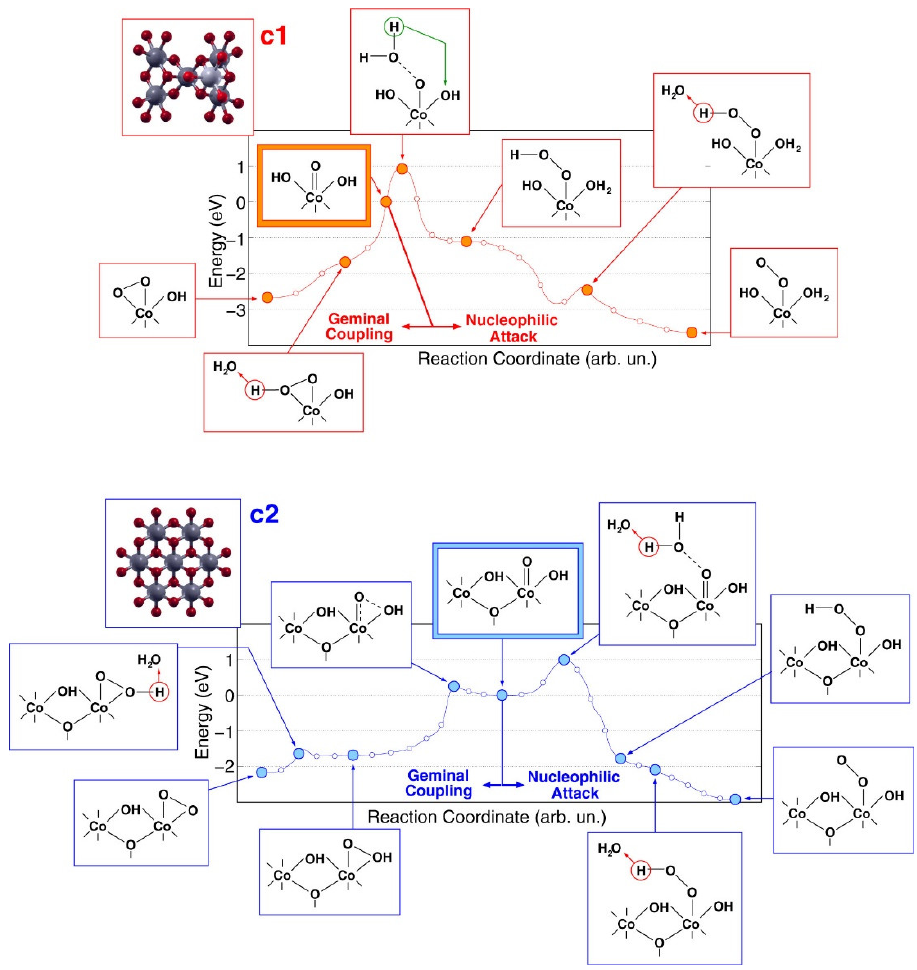
Figure 21. Reaction paths for oxygen evolution promoted by the c1 and c2 CoCat models. Details of the path A, including Co–O and O–O distances and spin-switching effects related to the formation of the O 2 molecule, are shown in the lower panel. (Reprinted from ref. [65] with permission from Journal of American Chemical Society. Copyright © 2013, American Chemical Society).